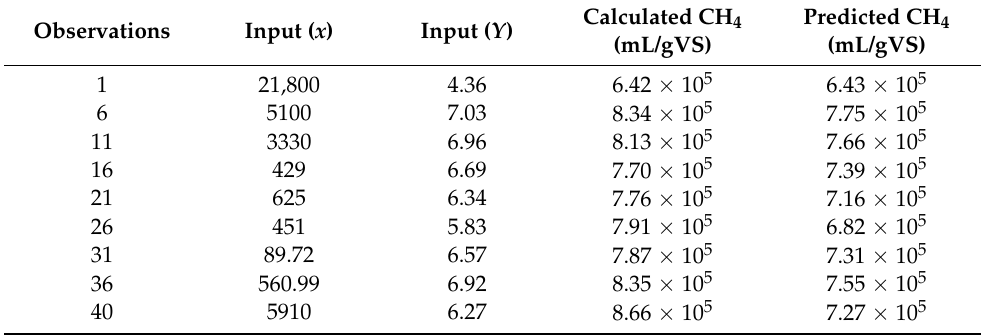
Table 7. Samples of inputs of calculated and predicted methane yield from test